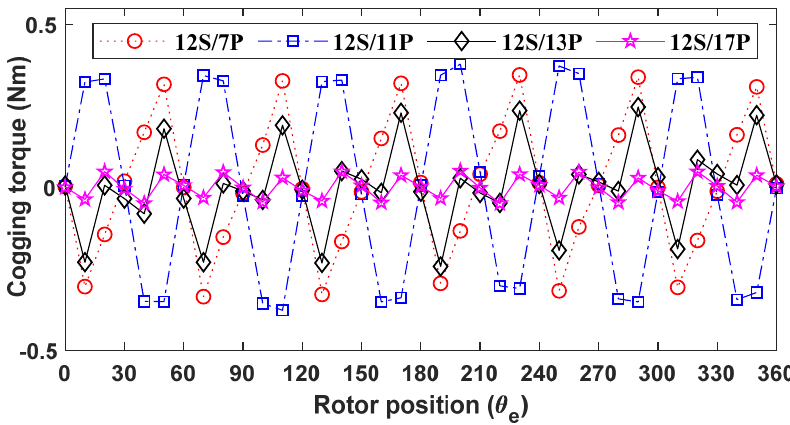
Figure 6. Variation of cogging torque profile.